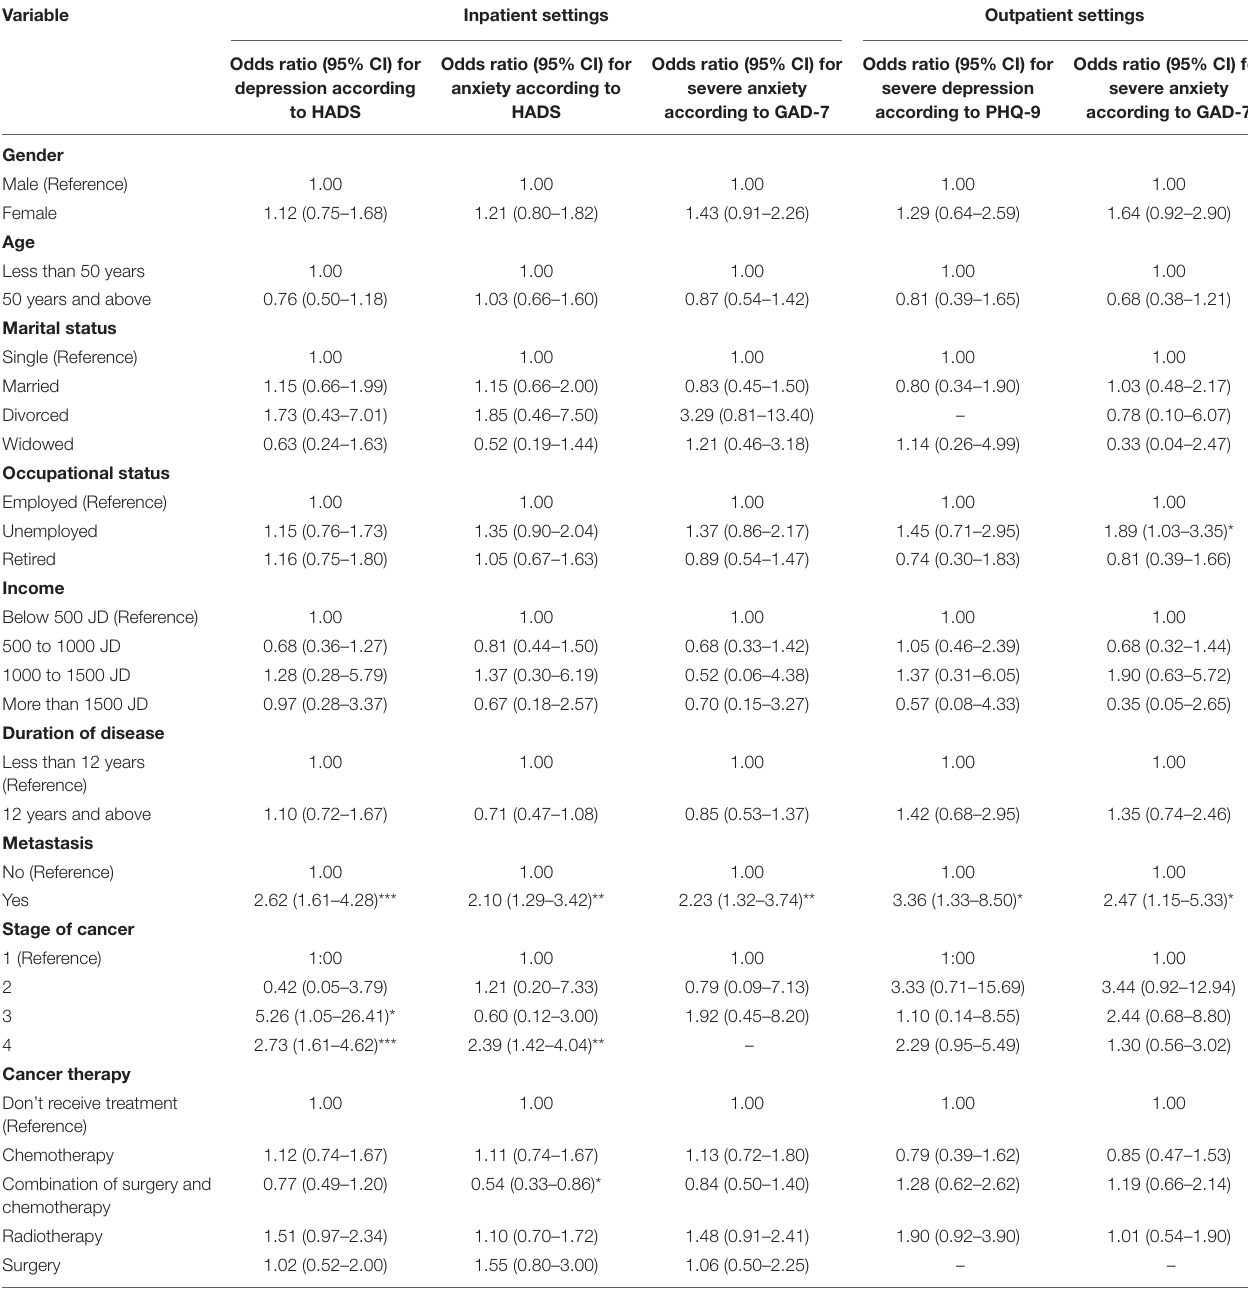
TABLE 4 | Logistic regression